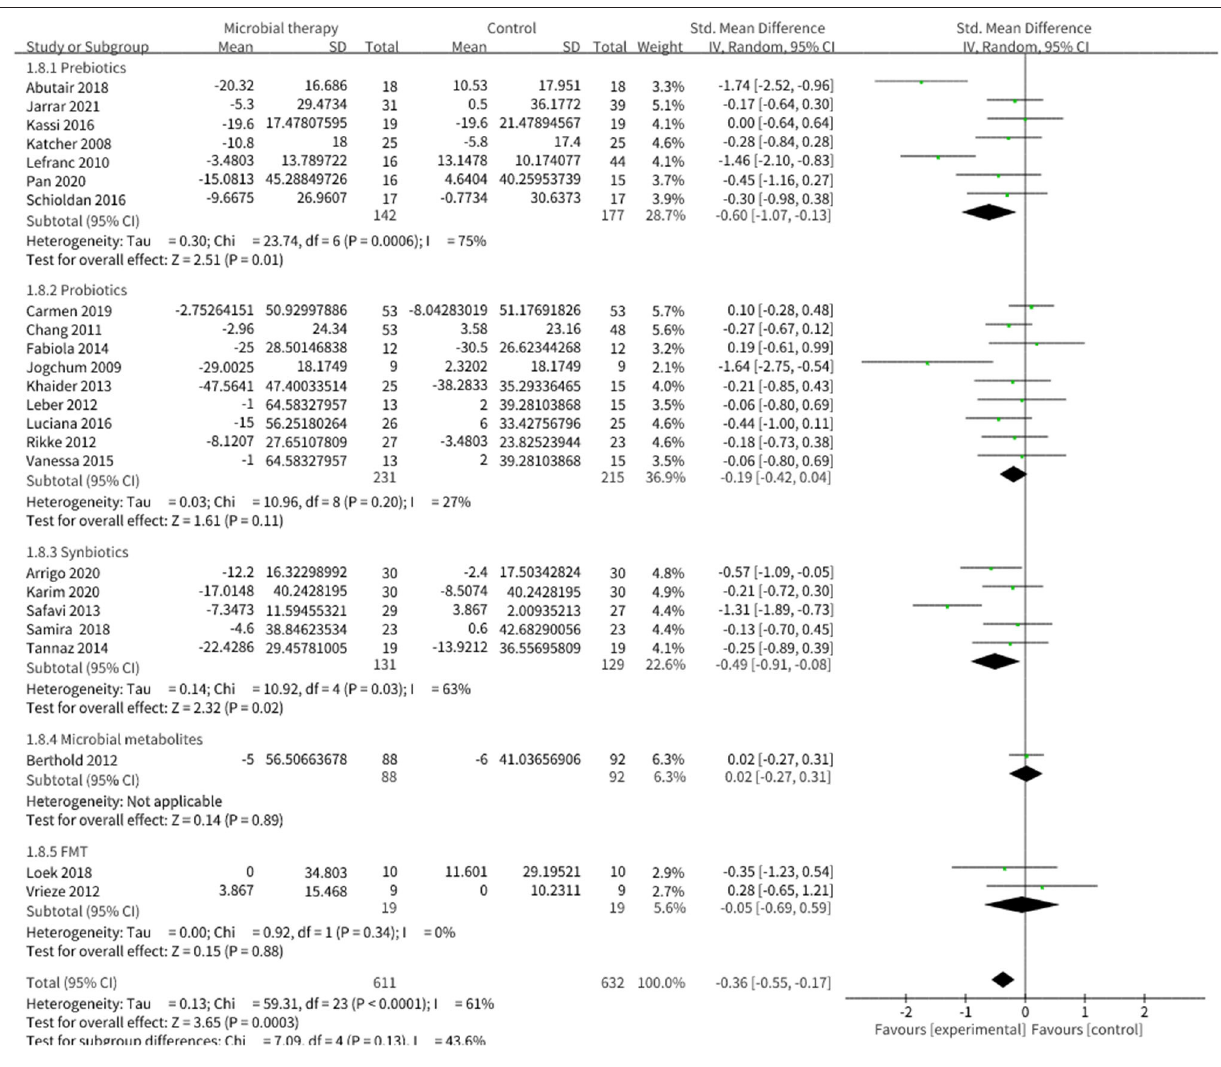
placebo (SMD = − 0.26, 95% CI − 0.49, − 0.03, P = 0.03) with moderate heterogeneity (I 2 = 57 %, p = 0.007). No